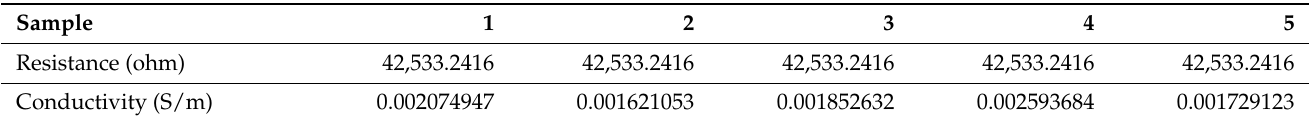
Table A15. Conductivity Data for Nylon 610 Nanocomposites with 4.5 wt% Graphite Nanosheets Treated at 150 ◦ C and − 1 bar.